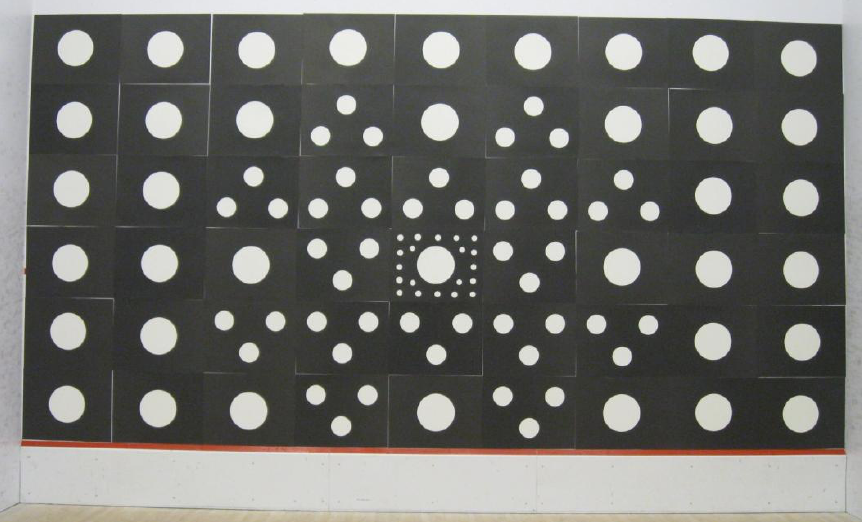
Figure 4. Calibration target field.